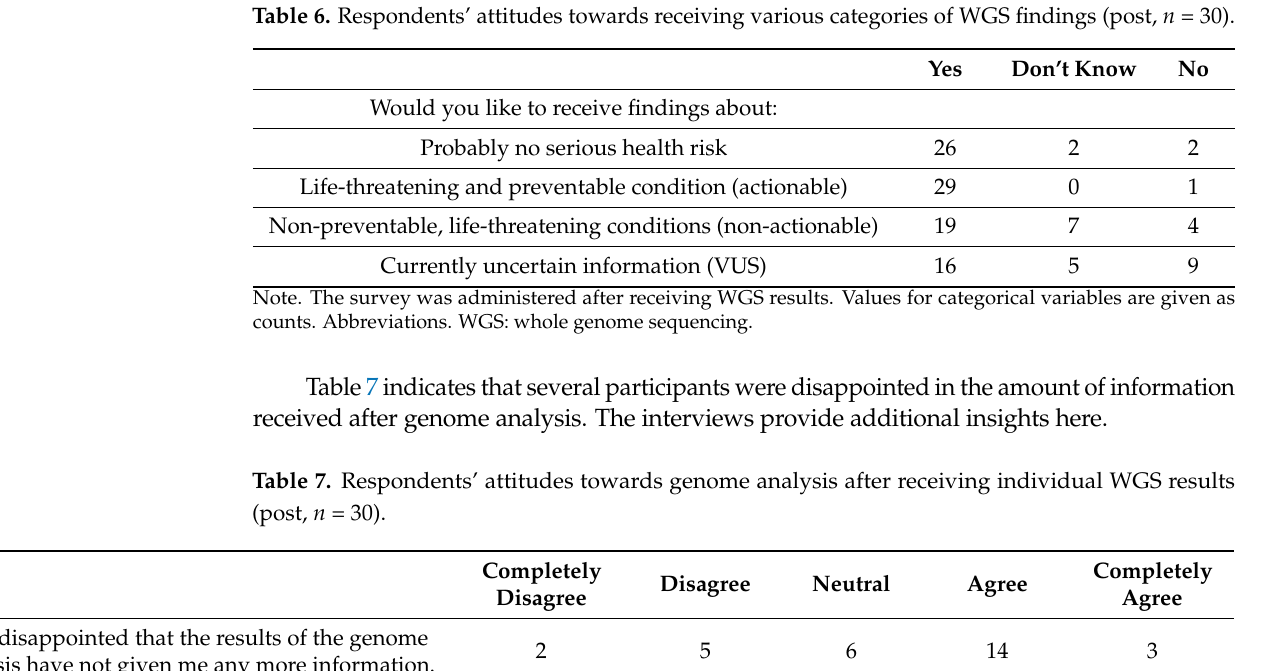
Completely Agree